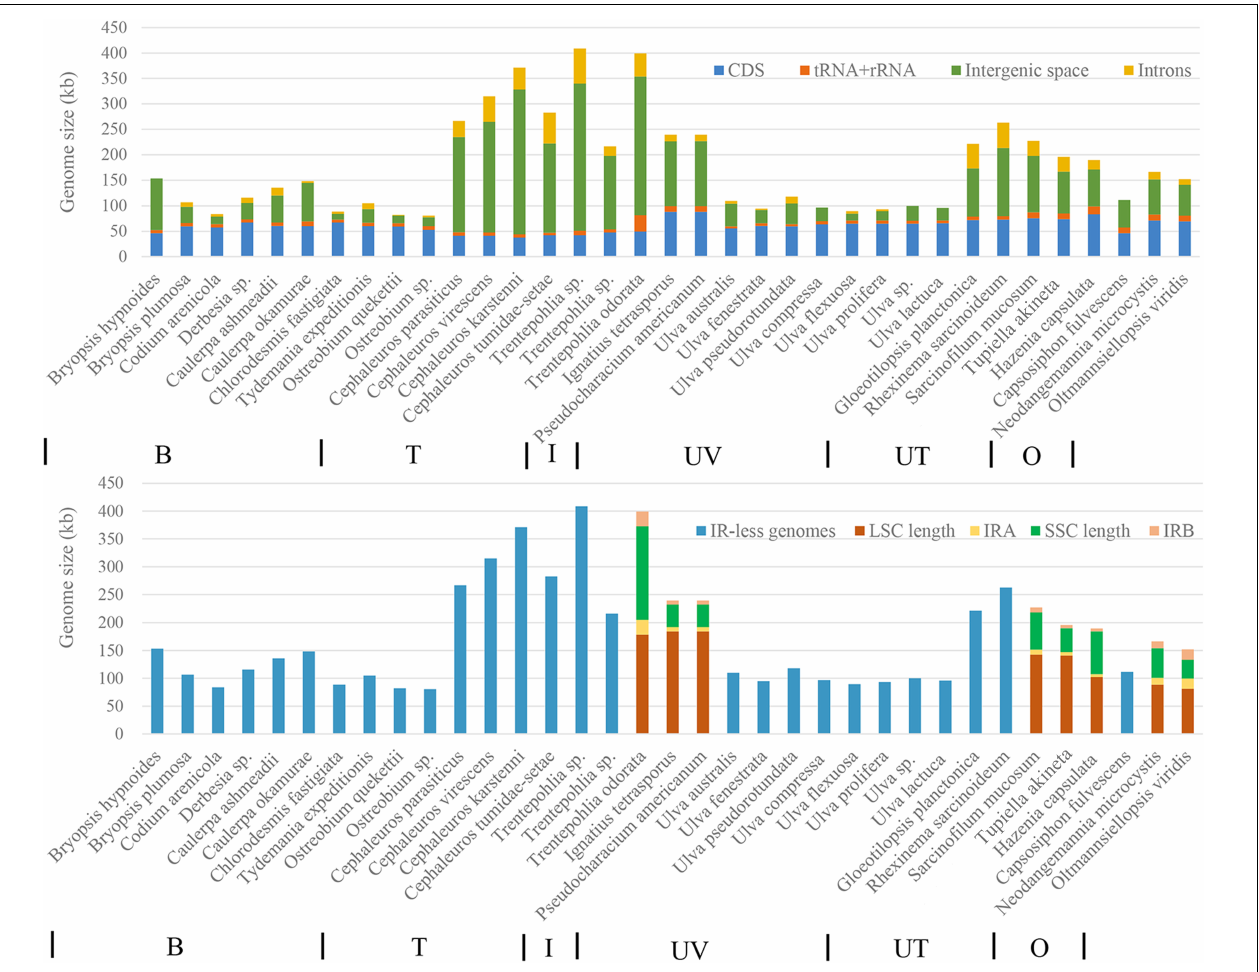
FIGURE 7 | Contribution of different features to the chloroplast genomes compared in this study. The top panel shows contributions of CDS, intronic, intergenic, and tRNA + rRNA. Note that CDS regions do not include hypothetical open reading frames (ORFs). The bottom panel shows sizes of the SSC, IR, and LSC regions. Chloroplast genomes lacking the IR are represented in blue. From left to right at the bottom of picture, B, T, I, UV, UT, and O represent the order Bryopsidales, Trentepohliales, Ignatiales, Ulvales, Ulotrichales, and